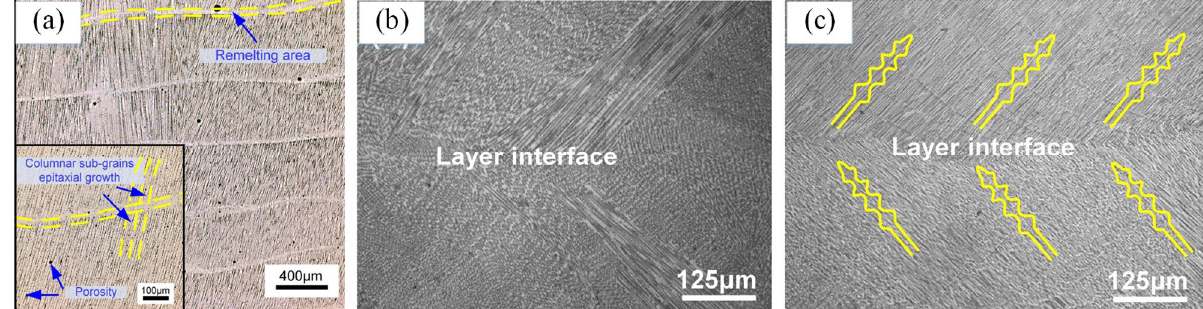
Figure 5. ( a ) Microstructure of CrCoNi medium-entropy alloy thin-wall (Reprinted from ref. [58], copyright (2021), with permission from Elsevier); microstructure of the IN718 thin-wall with the ( b ) continuous wave laser and ( c ) quasi-continuous-wave laser (Reprinted from ref. [54], copyright (2021), with permission from Elsevier).